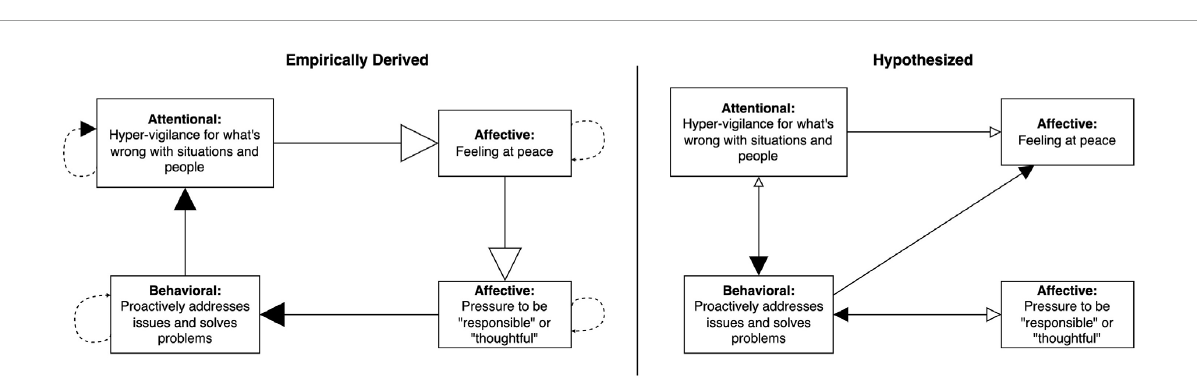
FIGURE8 Group Iterative Multiple Model Estimation (GIMME)-derived network showing contemporaneous and lagged relationships among EMA items completed by Amy in the first month of treatment on the left, compared to our hypothesized network on the right. Solid lines, contemporaneous; dashed lines, lagged; solid arrowhead, excitatory or positive relationship; blank arrowhead, inhibitory or negative relationship. Size of arrowheads corresponds to strength of relationship estimated by GIMME analyses. Beta estimates are presented in Supplementary Table S1 in Supplementary material